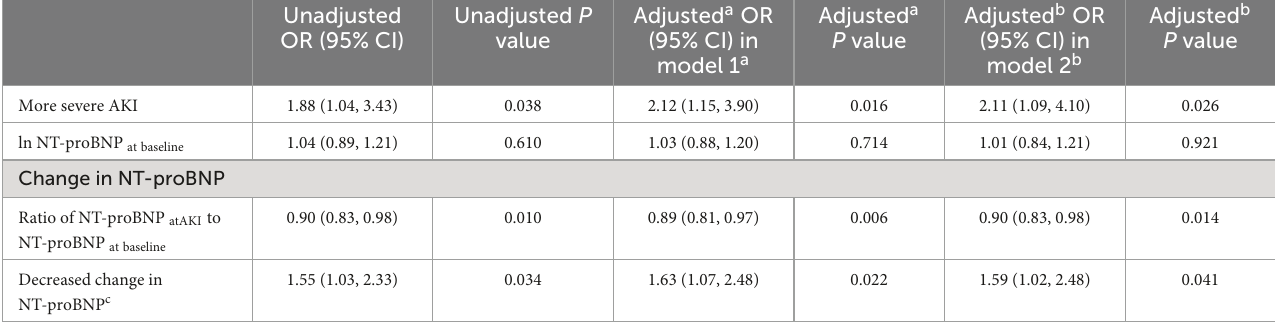
Unadjusted Unadjusted P Adjusted a OR Adjusted a OR (95% CI) value (95% CI) in model 1 a